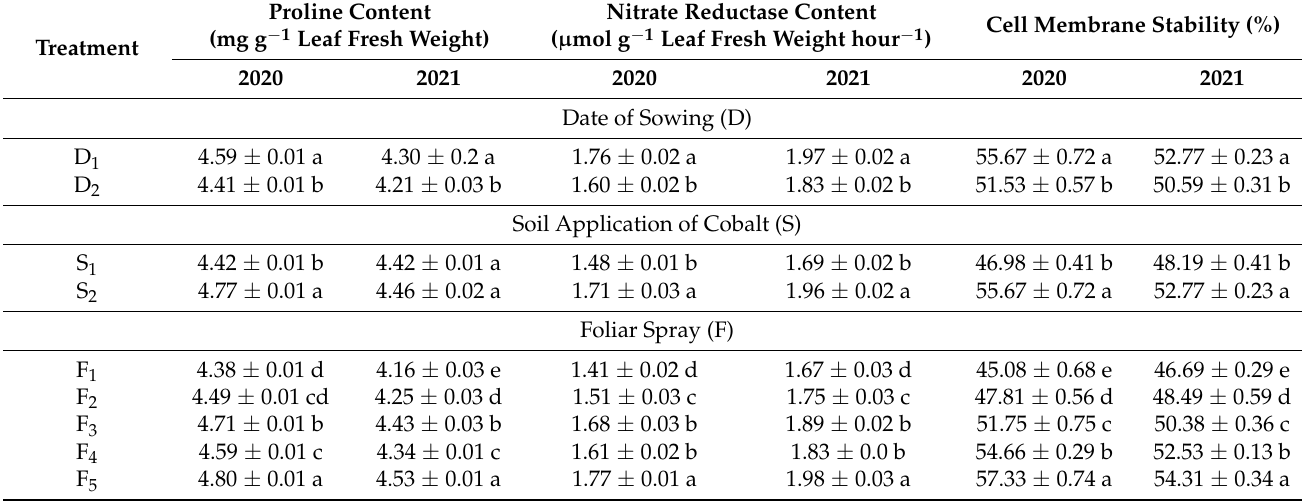
Values are means ± SEM (n = 3). Different letters designate significant differences between means. D 1 : March first week and D 2 : March third week;